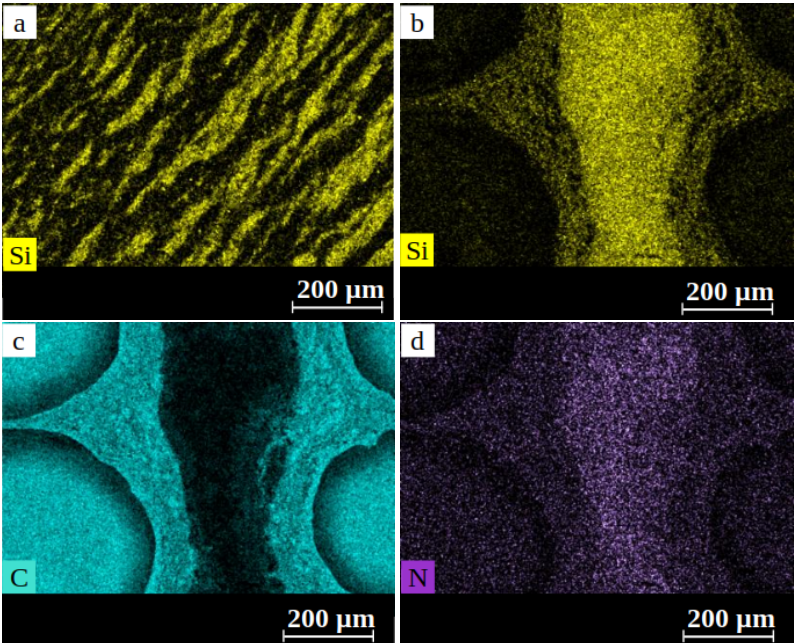
Figure 5. Elements distribution in polymer films of SB-MMT ( a ) and CSB-MMT ( b – d ). Magnifications 100 ×